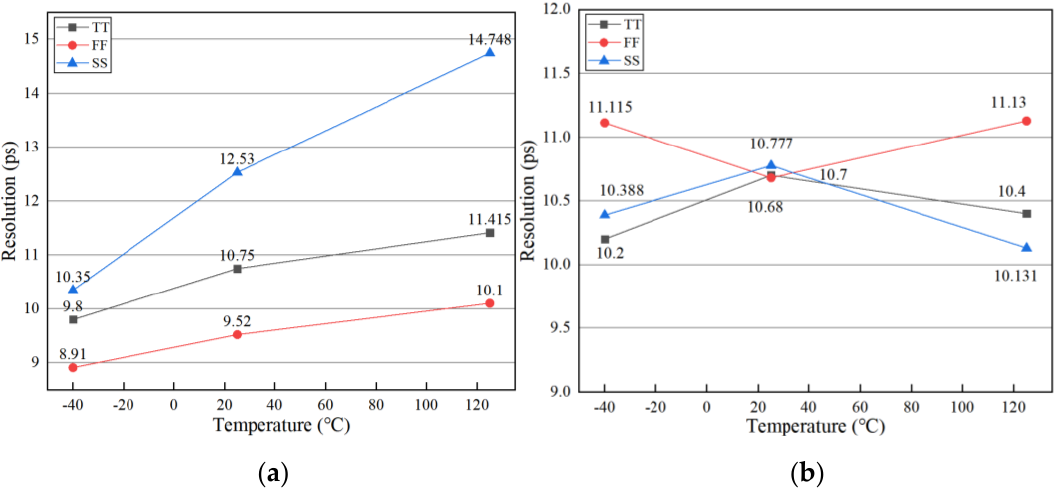
Figure 20. Resolution in Vernier TDC ( a ) Delay line without DLL; ( b ) Delay line with proposed ADDLL.